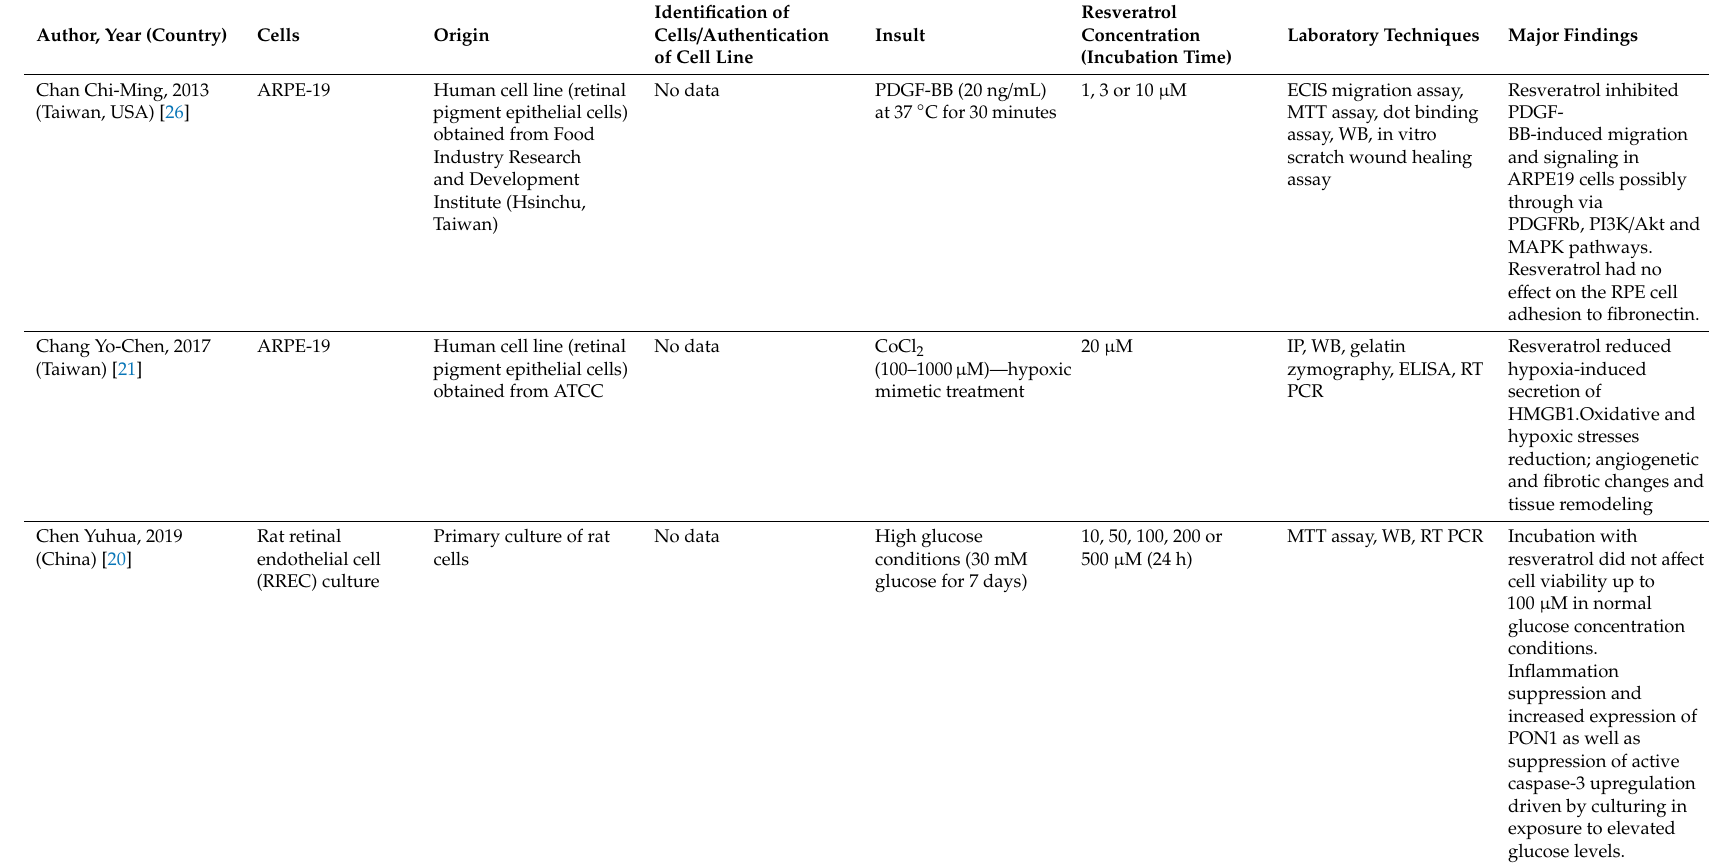
Table 1. In vitro studies on resveratrol e ff ect on cultured retinal